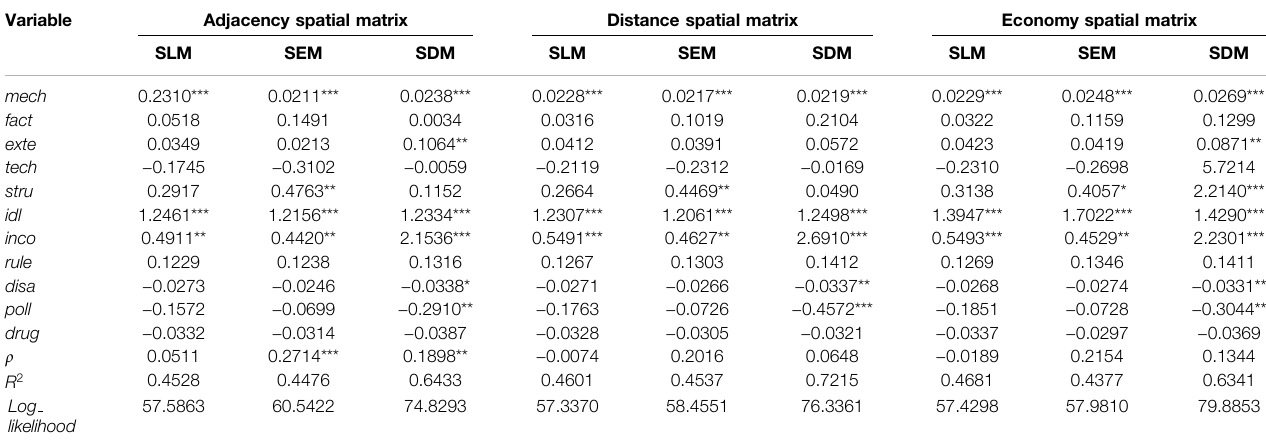
TABLE 6 | Model comparison estimation results of SLM, SEM, and SDM. Variable Adjacency spatial matrix Distance spatial matrix Economy spatial